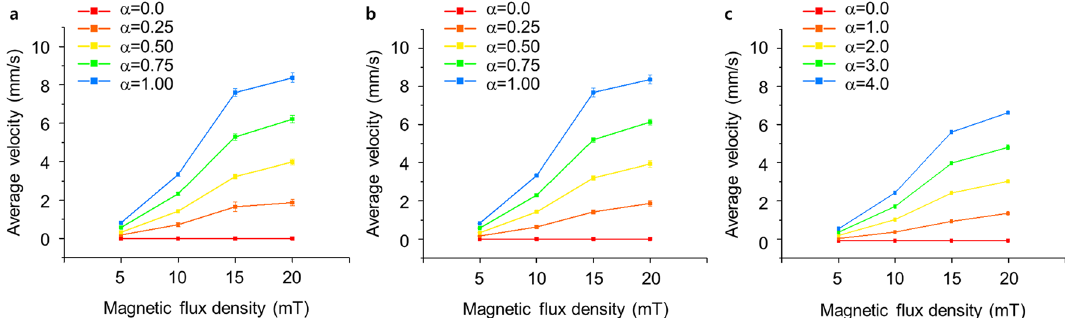
Figure 3. Average particle velocity according to the direction of motion. The average particle velocity in the ( a ) x- direction, ( b ) y- direction, and ( c ) z- direction where α is 0.00, 0.25, 0.50, 0.75, and 1.00 for the x- and y- directions and 0.0, 1.0, 2.0, 3.0, and 4.0 for the z- direction, and the magnetic flux density is 5, 10, 15, and 20 mT,